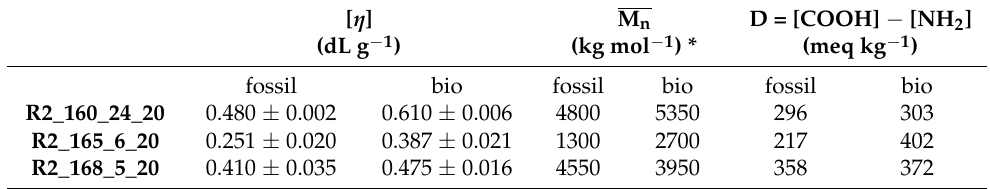
Table 7. Evaluation of time–temperature profiles tested: molecular size and end-group imbalance of R2 products.